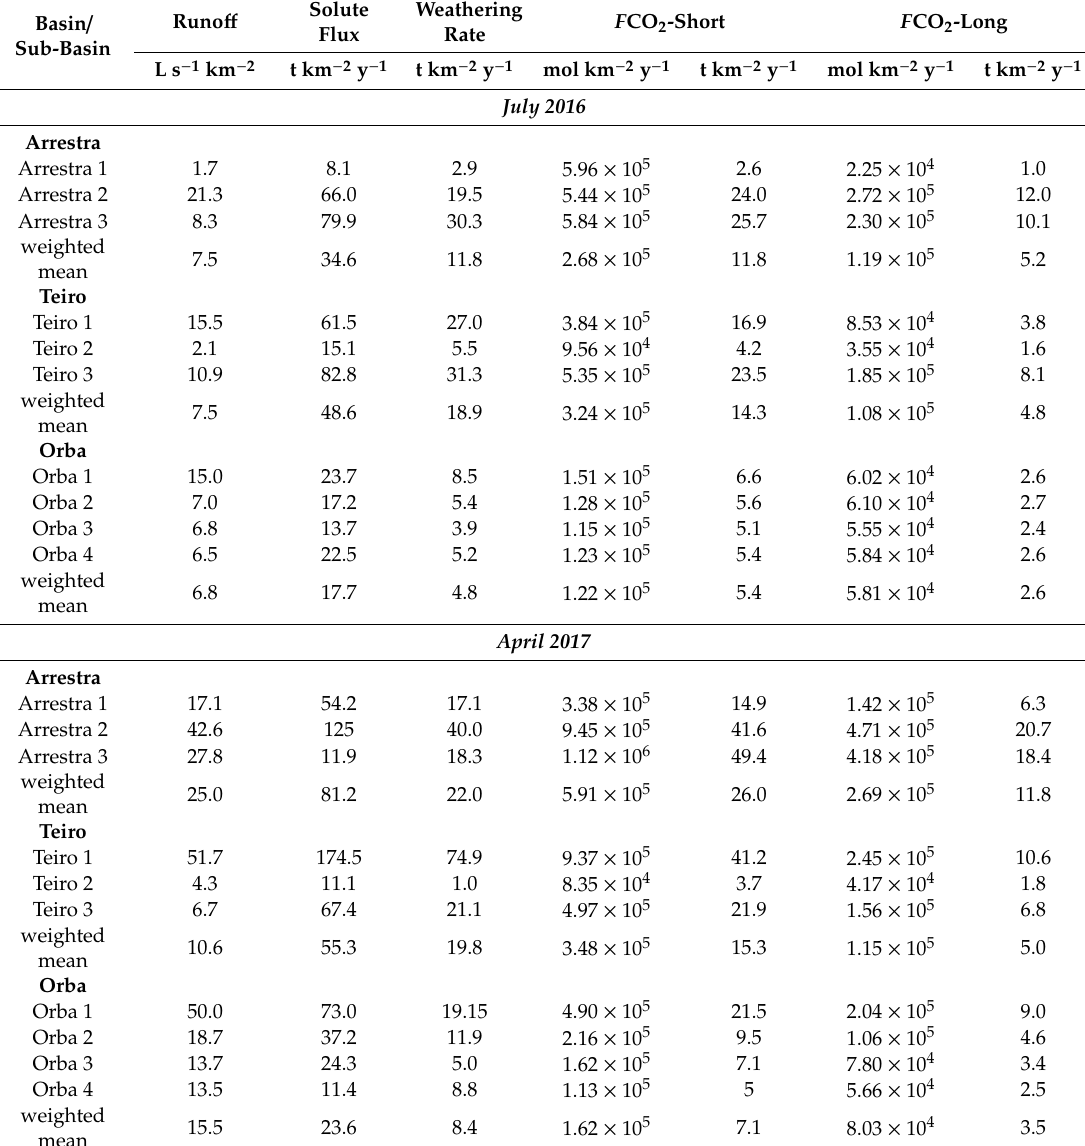
Table 4. Runo ff , solute flux, chemical weathering rates and fluxes of atmospheric CO 2 consumed by chemical weathering considering both the short and the long-term carbon cycles. F CO 2 data are reported both in mol km − 2 y − 1 and t km − 2 y − 1